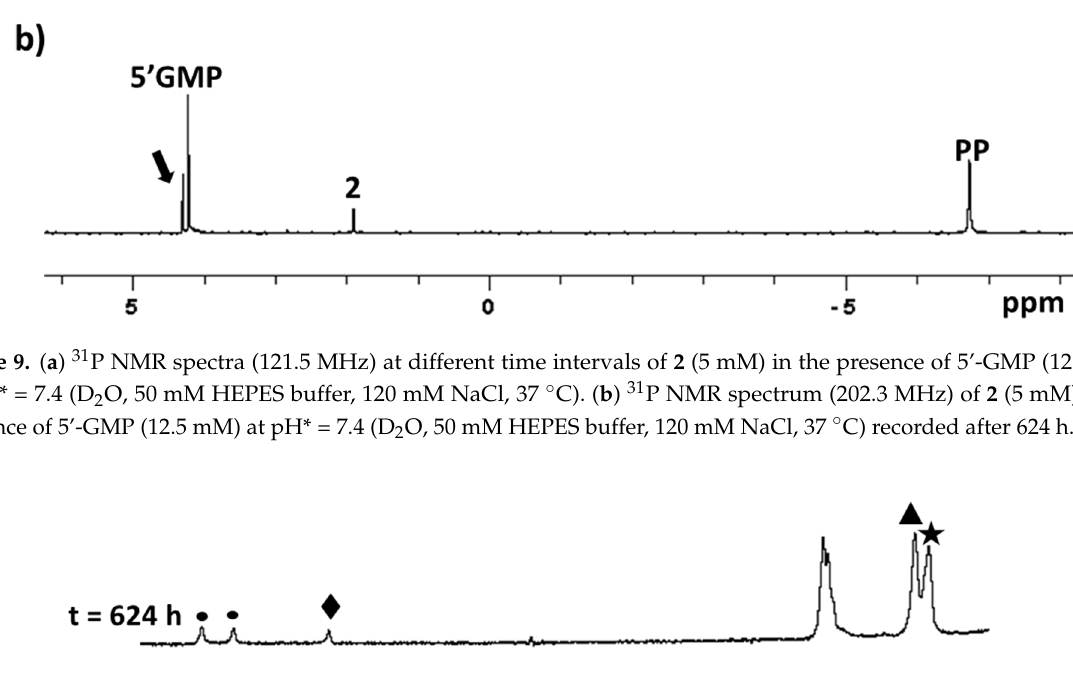
12 of 21 10) and the signals of the starting substrate (e.g., the vinylic protons of coordinated trans - 1,2-diamine-4-cyclohexene marked with a full star in Figure 10). After 336 h, 3 new signals falling at 5.54, 8.66, and 8.80 ppm could be observed. The peak at 5.54 ppm (marked with a full triangle in Figure 10) is assigned to the vinylic protons of DACHEX in the bis-adduct [Pt(5’-GMP) 2 (1,2-DACHEX)], while the signals at 8.66 and 8.80 ppm (marked with a full circle in Figure 10) are assigned to the H8 of the two coordinated 5’-GMPs, which are not equivalent due to the absence of a plane of symmetry passing through the cyclohexene ring. The three new signals grew in intensity with time, while the signals associated to complex 2 decreased.